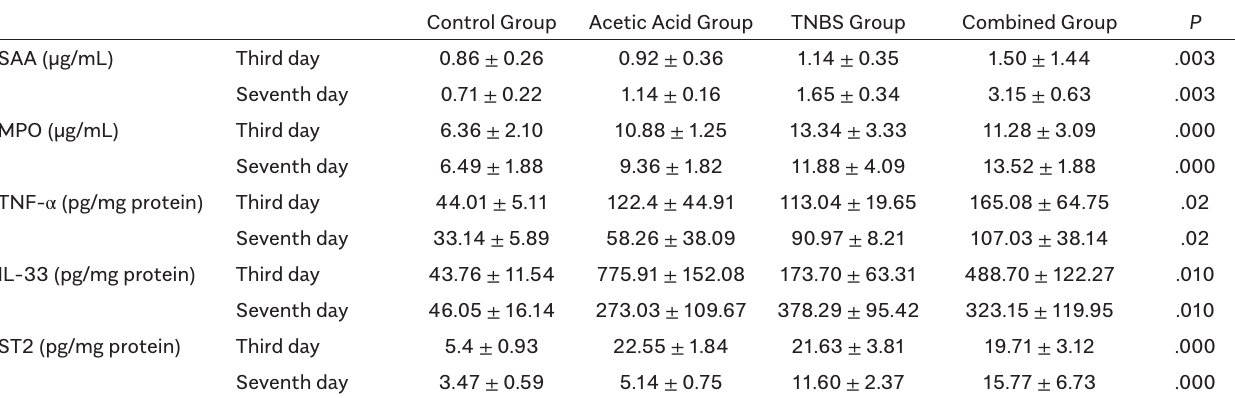
Table 2. The Results of the Biochemical Parameters of Control, Acetic Acid, TNBS, and Combined